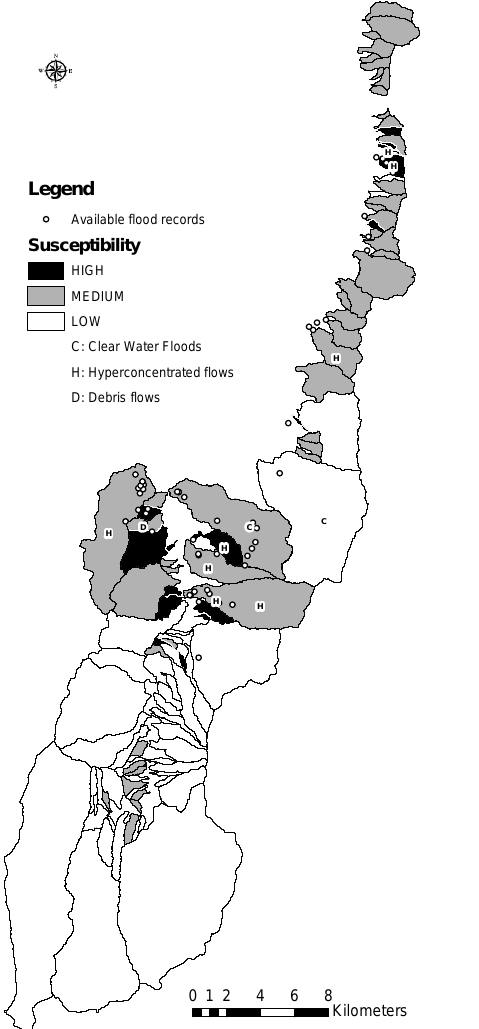
Figure 12. Susceptibility classification.